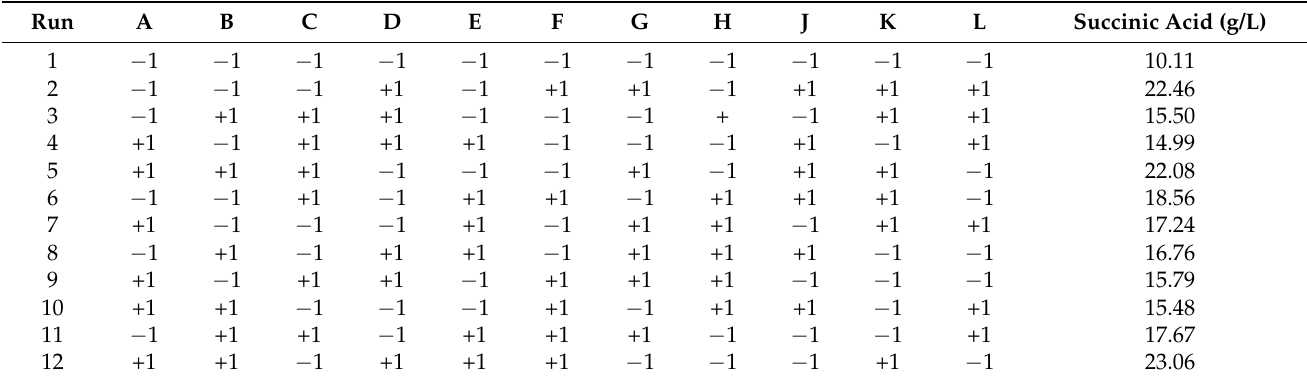
Table 3. Plackett–Burman design variables in code levels with succinic acid as a